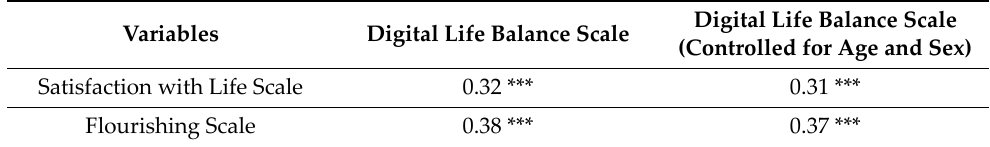
Table 3. Pearson’s correlation analysis for external validity assessment.